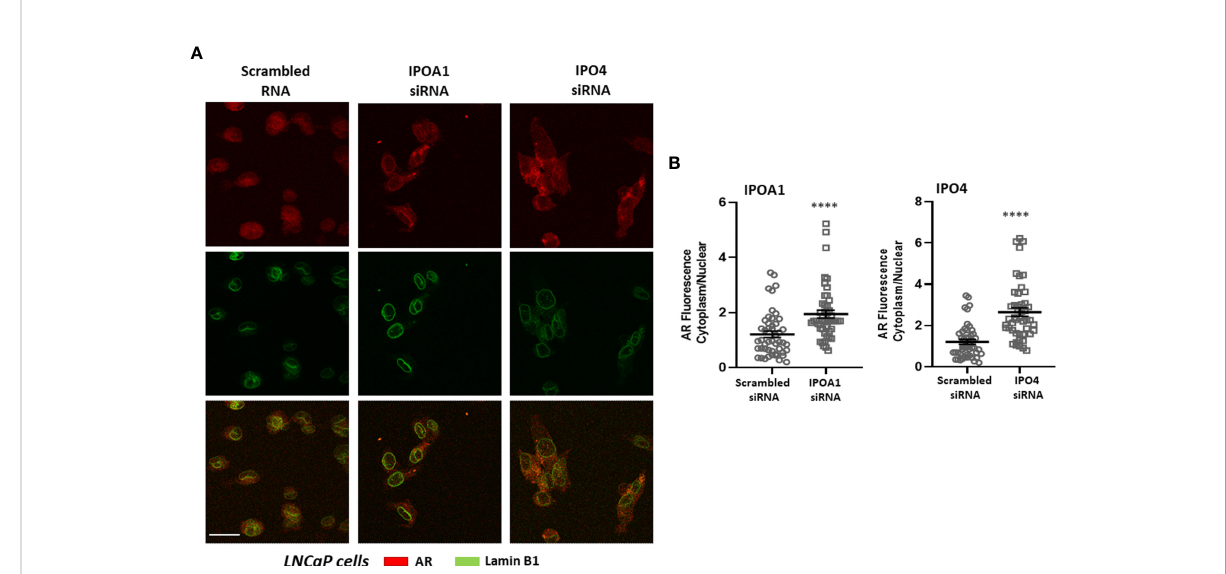
FIGURE 3 (A) Representative confocal pictures of LNCaP cells stained for androgen receptor (AR) (red) and lamin B1 (green) (3 rd raw is their overlay). LNCaP cells were transfected either with a scrambled siRNA or a speci fi c siRNA for importin a (IPOA1) or importin 4 (IPO4) and treated with DHT (10 -7 M) for 90 min to ensure nuclear localization. Magni fi cation x1260 (scale bar, 40 m m). (B) Intensity of fl uorescence in the cytoplasm and nucleus was quanti fi ed (see Material and Methods for details) in at least 50 cells from 4 independent experiments (n=4) and is given as the Cytoplasm/Nuclear fl uorescence ratio in each condition. **** denotes statistical signi fi cance P<